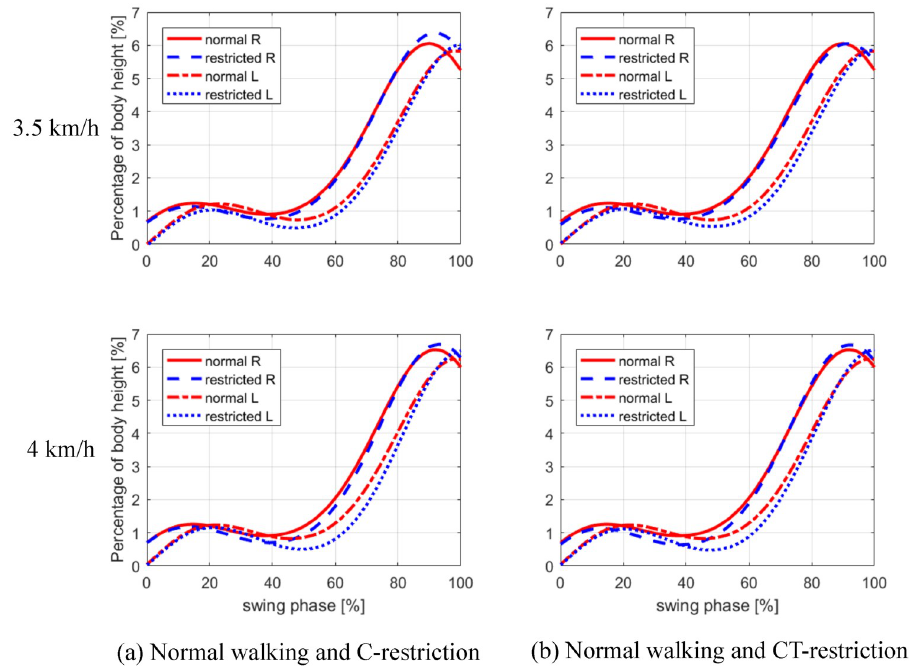
Fig 3. Average toe clearance during the swing phase. The MTC is the lowest point observed in the middle-swing phase, and is located between 40-50% of the swing phase. The MTC in restricted walking (C- and CT-restriction cases) is lower than that in normal walking for the right (R) and left (L) legs, at both 3.5 km/h and 4 km/h walking speeds.